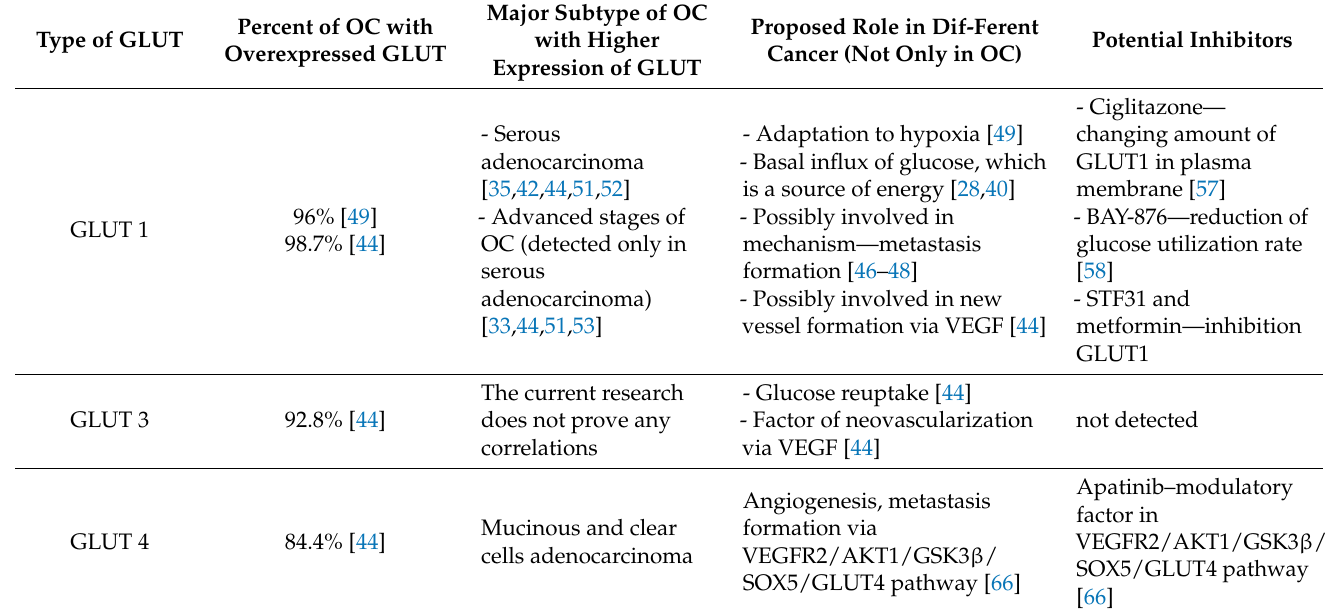
Table 1. Facilitative glucose transporters in ovarian cancer—an